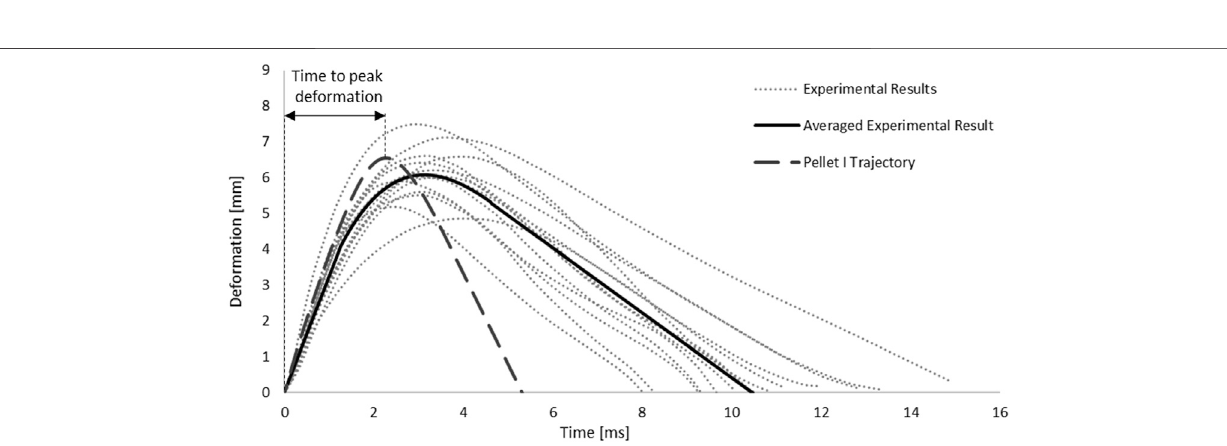
Frontiers in Bioengineering and Biotechnology |